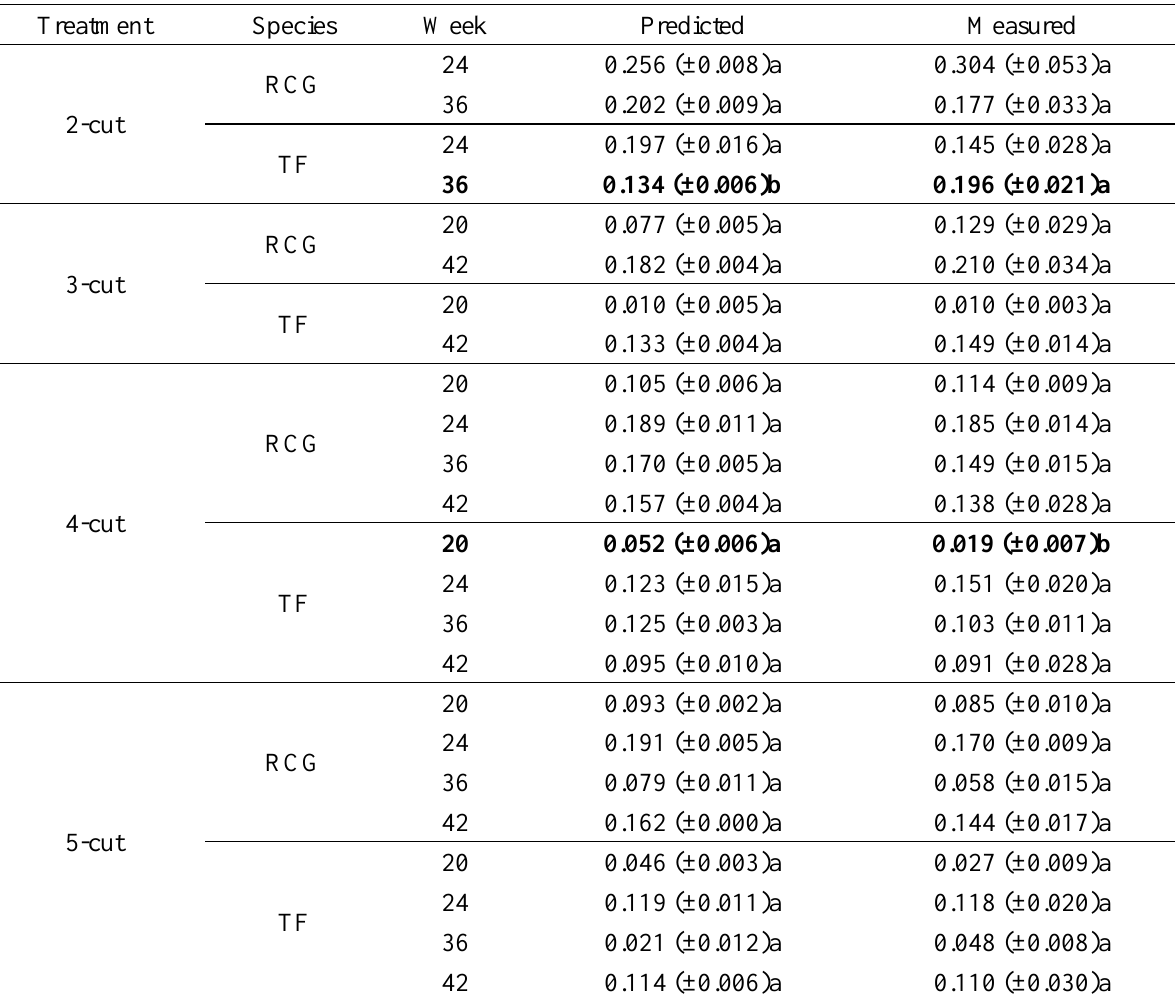
Table 2. Crude protein yields (t ha -1 ) in the protein precipitate for all annual harvest frequencies as indicated by the treatments (2-cut to 5-cut) and both species ( Phalaris arundinacea (RCG) and Festuca arundinacea (TF)) per harvest week as predicted by the model and as measured. Standard error (n = 4) is shown in brackets. Letters indicate differences between means; treatments with the same letter are not significantly different and bold type highlights (the two) significant differences. Missing data could not be determined due to technical difficulties, resulting in omitted values for the 3-cut and 5-cut treatments at harvest week 32 owing to insufficient